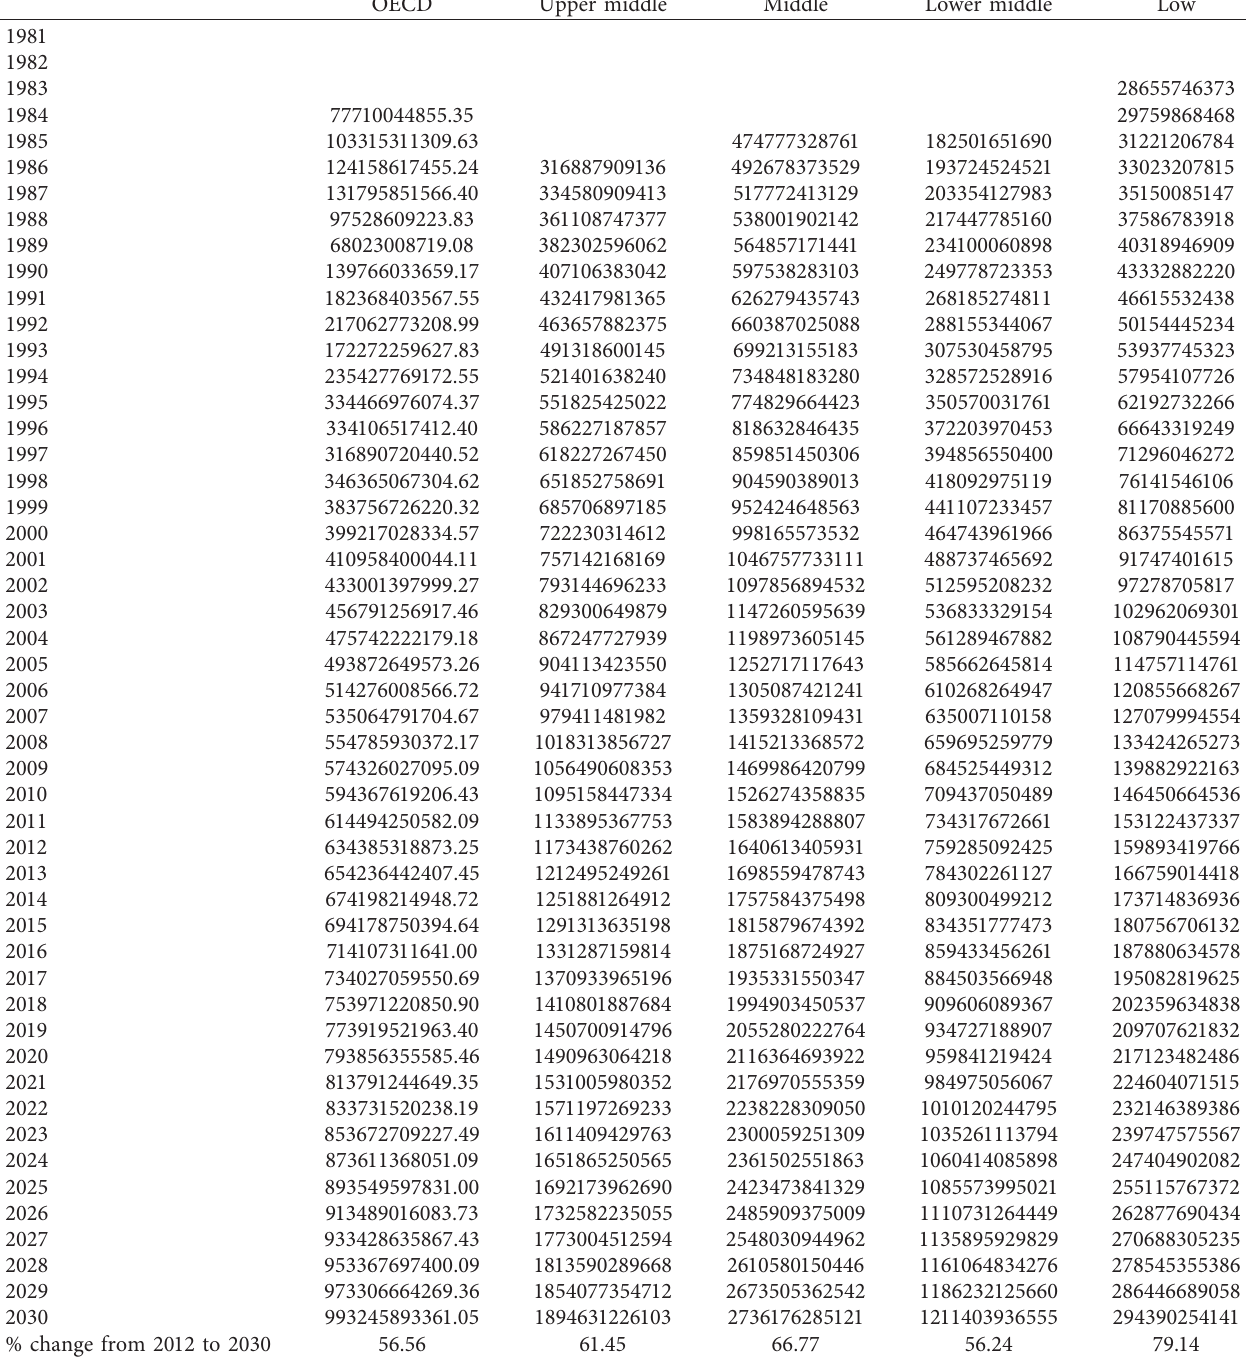
Table 5: Forecasted values of agriculture output in current USD under the BJ